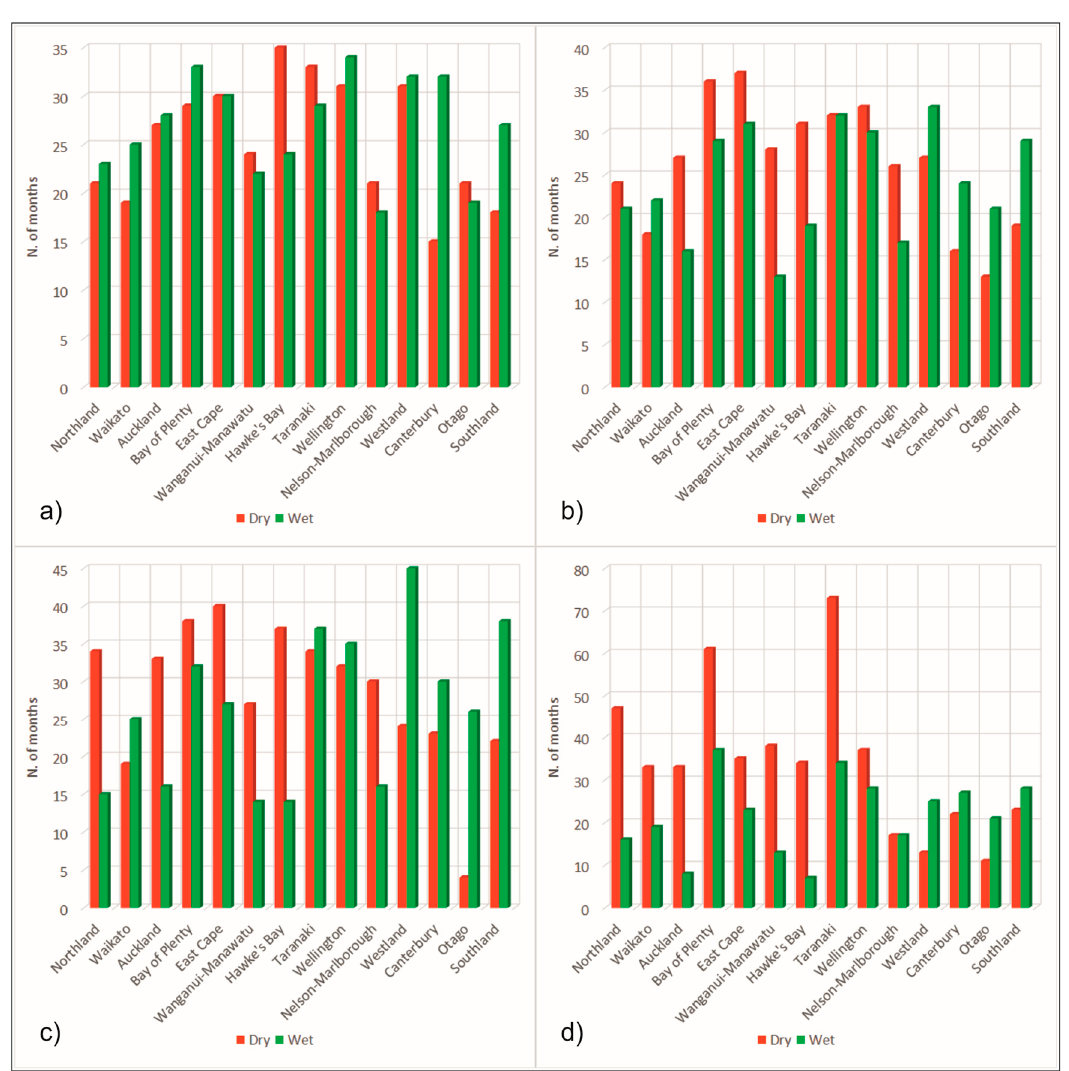
Figure 3. Number of months showing severe or extreme dry and wet conditions for the 3-month ( a ), 6-month ( b ), 12-month ( c ), and 24-month SPI ( d ). 6-month ( b ); 12-month ( c ); and 24-month SPI ( d